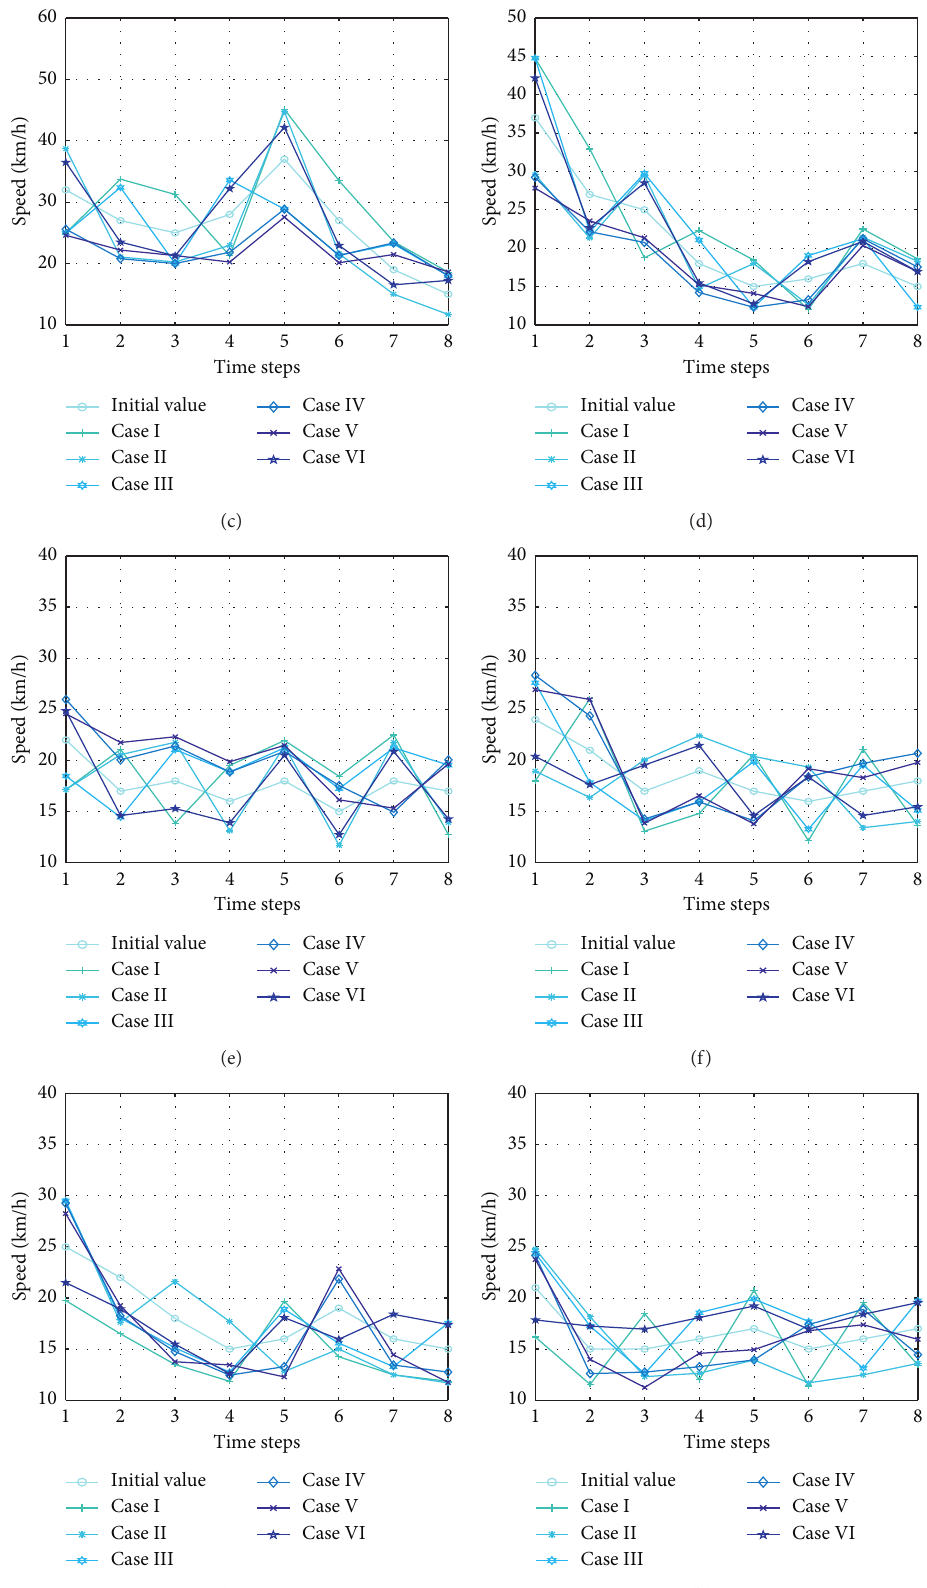
Figure 6: The prediction results of average speed. (a) Area 1, (b) area 2, (c) area 3, (d) area 4, (e) area 5, (f) area 6, (g) area 7, and (h) Area